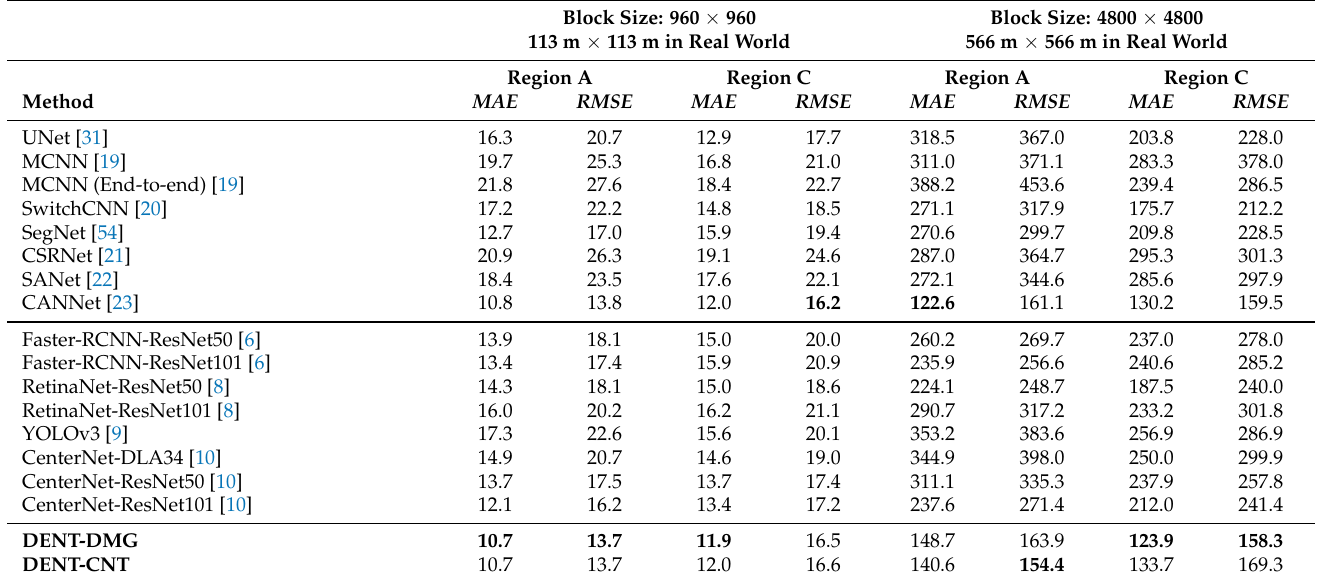
Table 1. Counting errors of different approaches on Yosemite Tree Dataset. The bold numbers are the lowest values in each column.